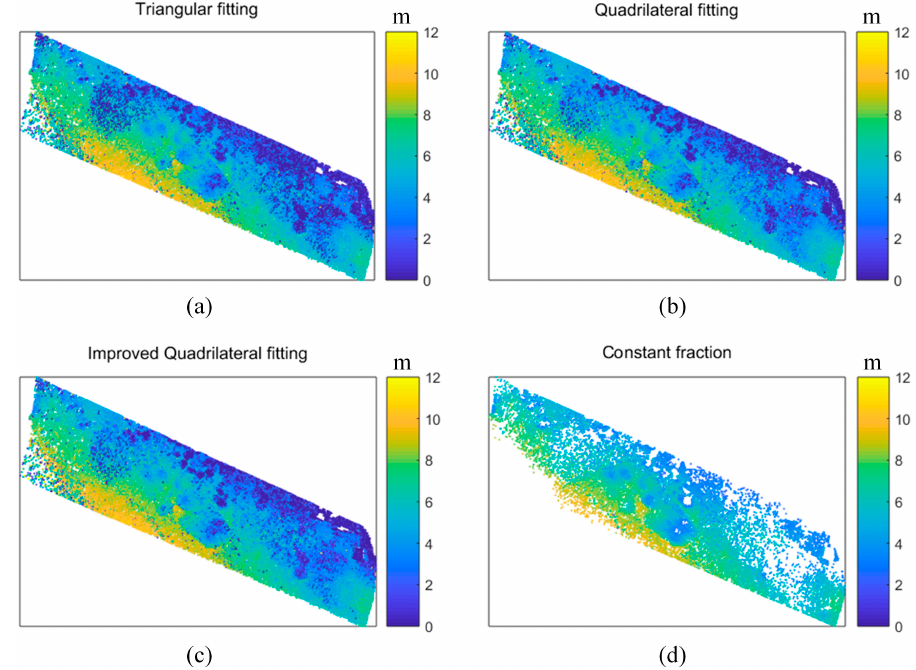
Figure 5. Bathymetry maps from all the algorithms: ( a ) Triangular fitting algorithm; ( b ) Quadrilateral fitting algorithm; ( c ) Improved quadrilateral fitting algorithm, and ( d ) CFD from the Aquarius data.